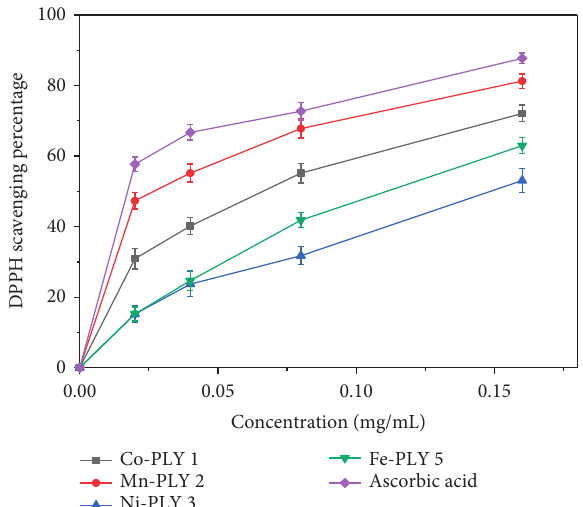
Figure 4: Graphical representation of the DPPH scavenging activity of metal-PLY complexes. Table 5: DPPH scavenging capacity (IC 50 , mg/mL) of the standard (ascorbic acid) and the metal-PLY complexes. Compound Co-PLY 1 Mn-PLY 2 Ni-PLY 3 Fe-PLY 5 Ascorbic acid IC 50 (mg/mL)